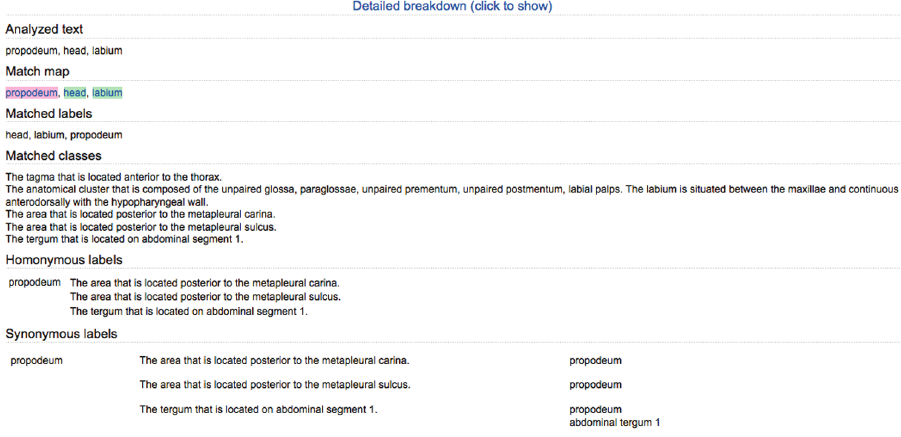
Figure 3. The detailed breakdown report from an analyzer report. See Using the “analyzer” tool for